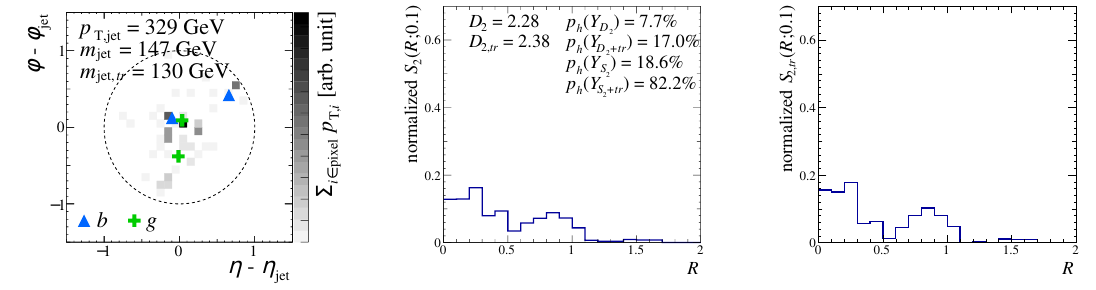
Figure 12 . The Pixelated jet image (left), two-point spectrum S 2 ( R ; 0 : 1) (center), and trimmed spectrum S 2 ( R ; 0 : 1) (right) of a Higgs jet which is Higgs-like only in the N S bins of each spectrum is normalized to 1. The blue triangles and green plus symbols in the pixelated jet images indicate direction of b quarks and gluons obtained from the matrix element including order (cid:11) S radiations. We show the Higgs-like probability p h ( Y X ) in an ANN model N X de(cid:12)ned by eq.